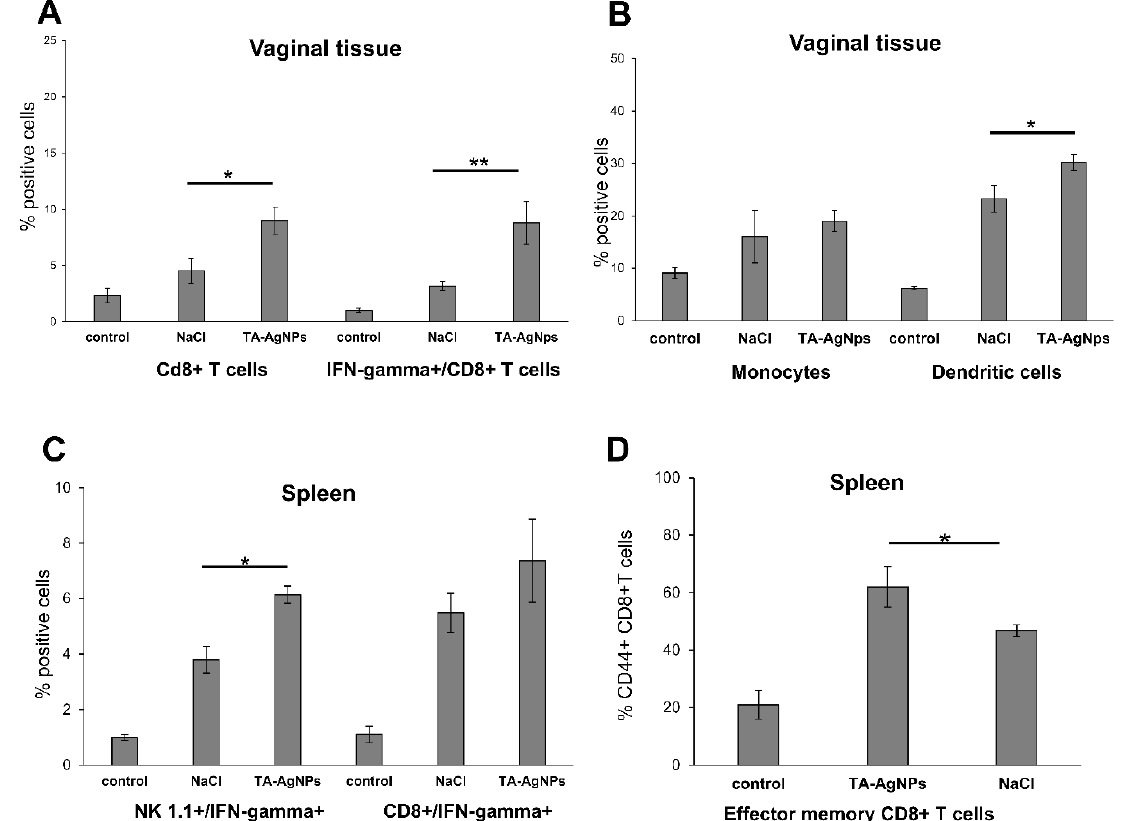
Figure 4. Treatment with TA-AgNPs helps to boost T and NK cells ’ response after re-challenge. C57BL6 mice were infected intravaginally with HSV-2, then treated with 5 µg/mouse of TA-AgNPs 6, 24, and 48 h after infection. Thirty days later, the mice were re-challenged with the same virus dose. The cell suspensions from the vaginal tissues and spleens were prepared 10 days after re-challenge. The percentage of CD8+ T cells and CD8+/IFN-gamma+ T cells ( A ), and monocytes and dendritic cells ( B ) in the vaginal tissue, as well as the percentage of NK1.1/IFN-gamma+ cells and CD8+/IFN-gamma+ T cells ( C ), and the effector memory CD8+ T cells ( D ) were accessed by flow cytometry. The means are expressed as mean ± SEM for n = 20; * represents significant differences with p ≤ 0.05, while ** means p ≤ 0.01. Table 2. Cytokine and chemokine expression changes in the vaginal tissues at 10 days after re-challenge with HSV-2. The vaginal tissues were earlier subjected to treatment with TA-AgNPs during primary HSV-2 infection. The mRNA levels of the IFN-alpha, IFN-gamma, CXCL9, CXCL10, and CXCL17 are shown as an expression relative to the control, on the basis of the 2 − ∆∆ Ct method. The mRNA levels were calculated from three PCR reactions for each sample. n = 10. ** p ≤ 0.001 versus NaCl-treatment. HSV-2 + NaCl